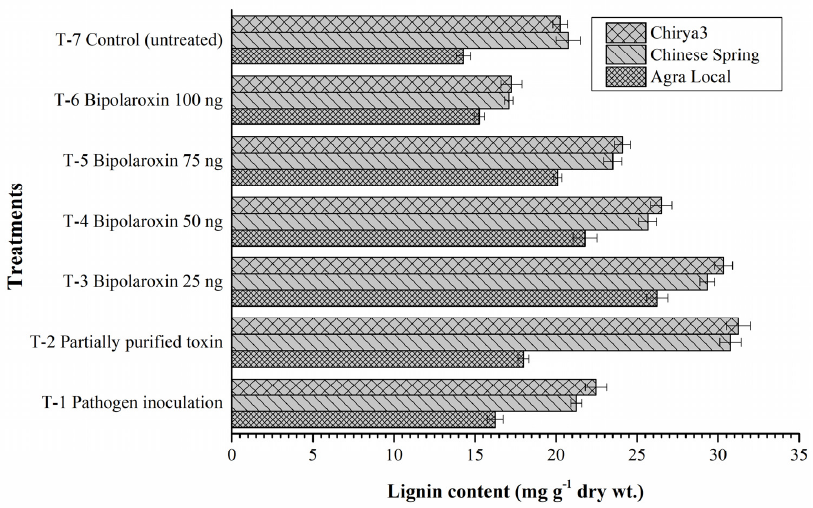
Figure 16. Effects of different treatments on lignin content in the susceptible and resistant lines/cultivars of wheat at 30 days under pathogen inoculation and infiltration of partially purified toxin obtained from B. sorokiniana as well as chemically synthesized Bipolaroxin. Data are mean ( n = 5) and vertical lines represent the standard deviation (Mean ± SD).